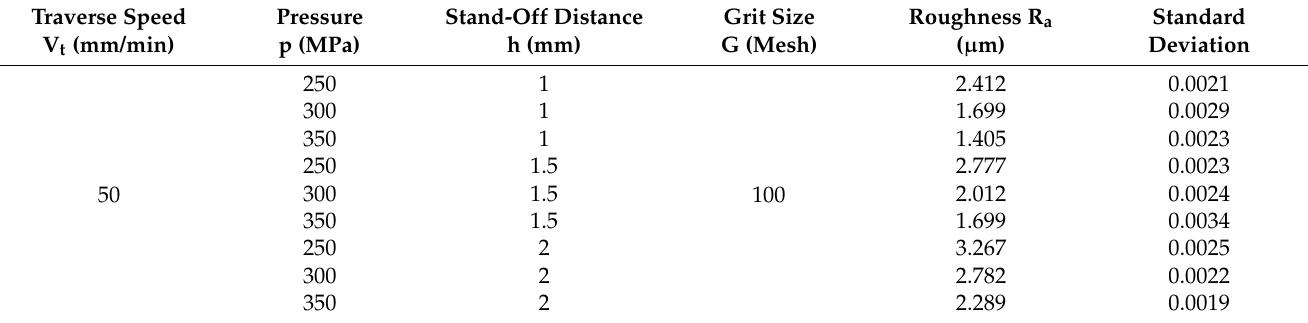
Table 5. Roughness values obtained upon adjusting waterjet pressure and stand-off distance. Traverse Speed